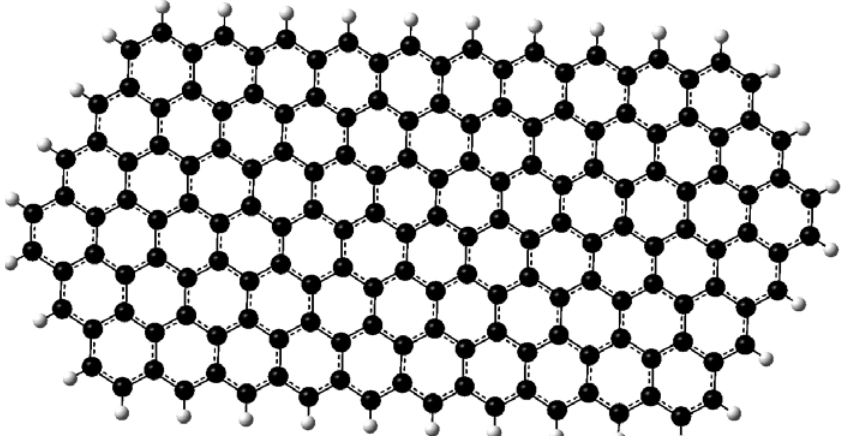
Fig. 1. The chemical structure of graphene